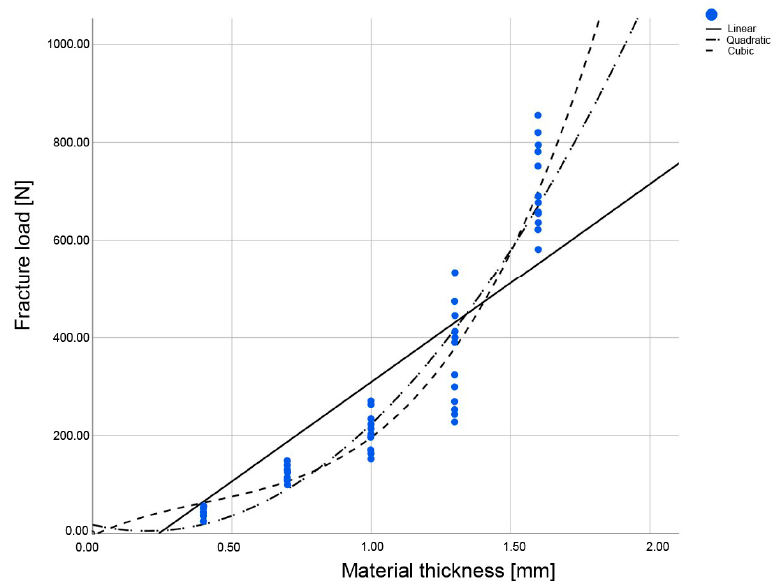
Figure 4. Regression curves of the fracture load values for the IPS Empress CAD LT A2 (ESS), with specimens in the five different material thicknesses examined.